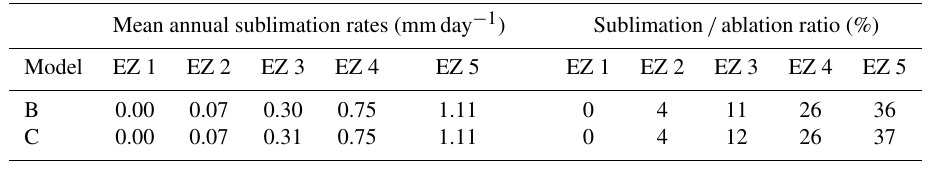
Table 5. Sublimation rates and contribution to snow ablation over the period 2000–2011. These results are for Models B and C and for the five elevation zones (EZs).